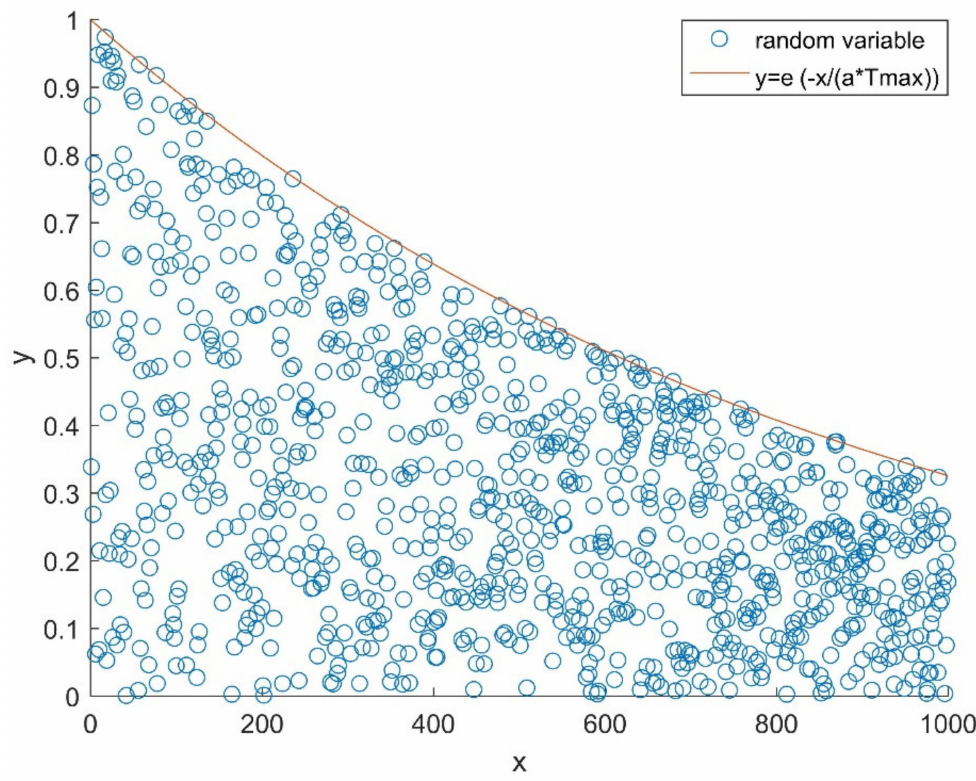
Figure 1. Distribution of the random variables between 0 and y